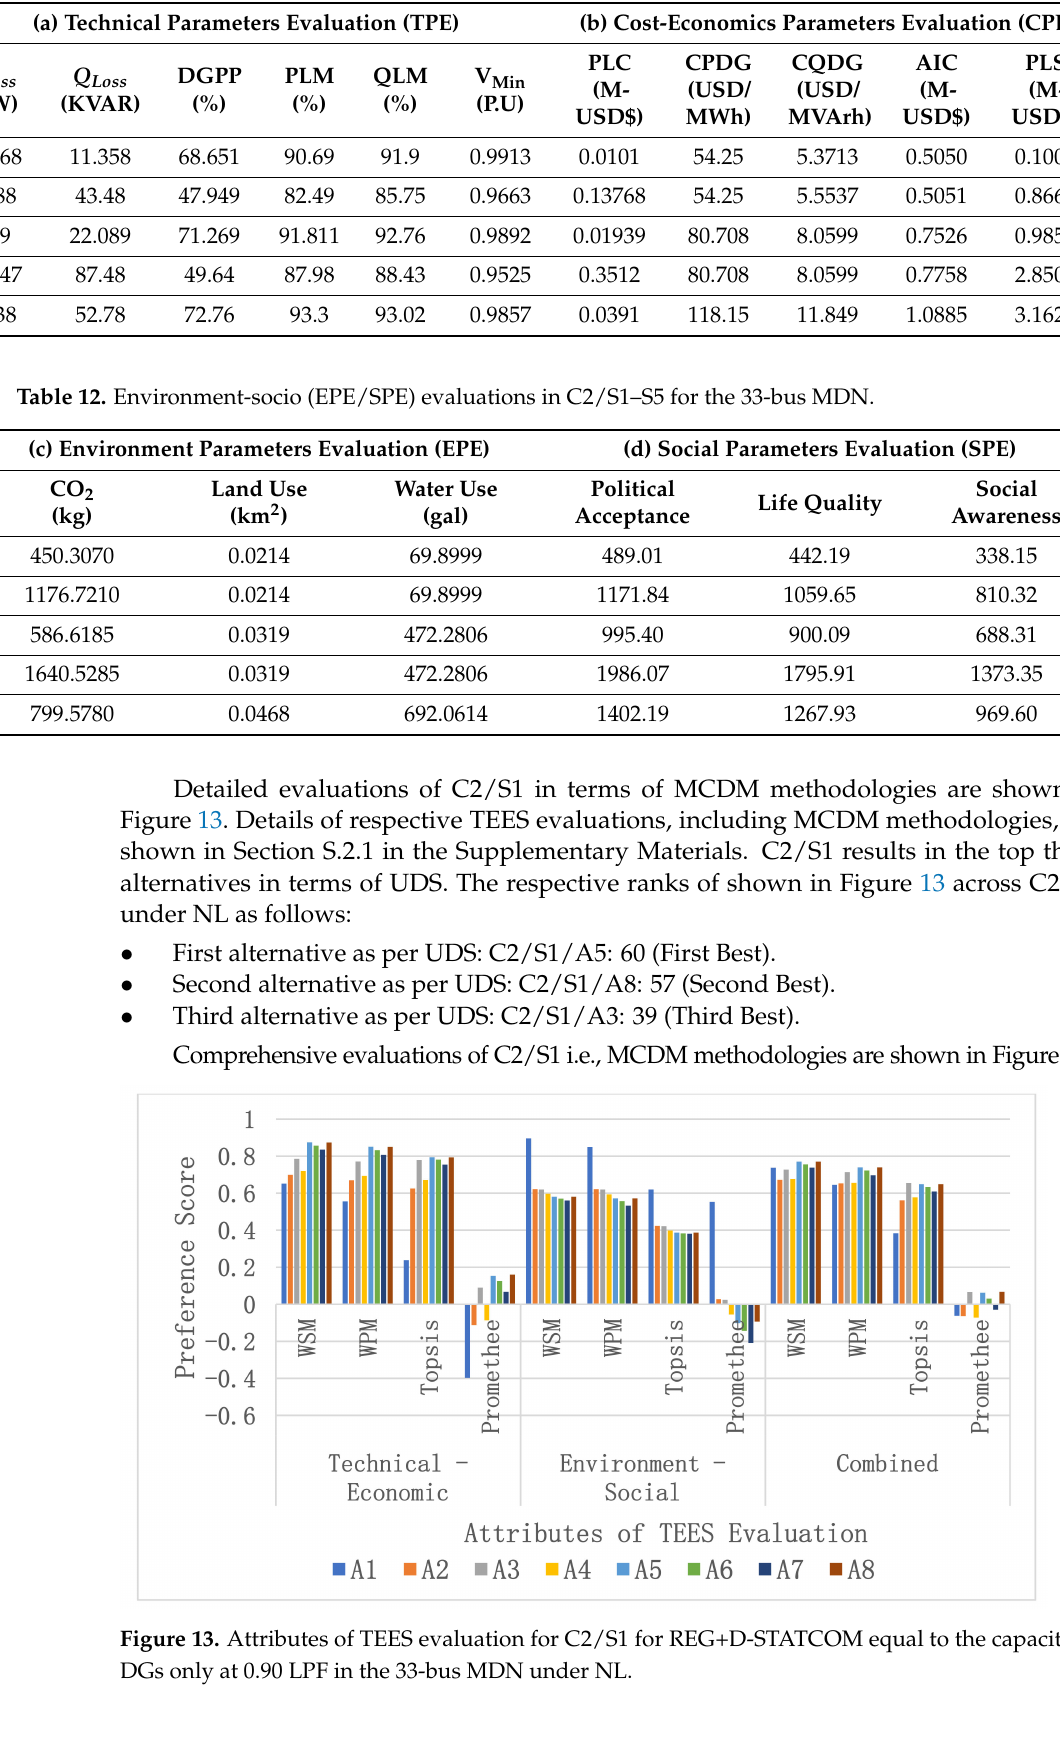
Table 11. Techno-economic (TPE/CPE) evaluations in C2/S1–S5 for the 33-bus MDN.